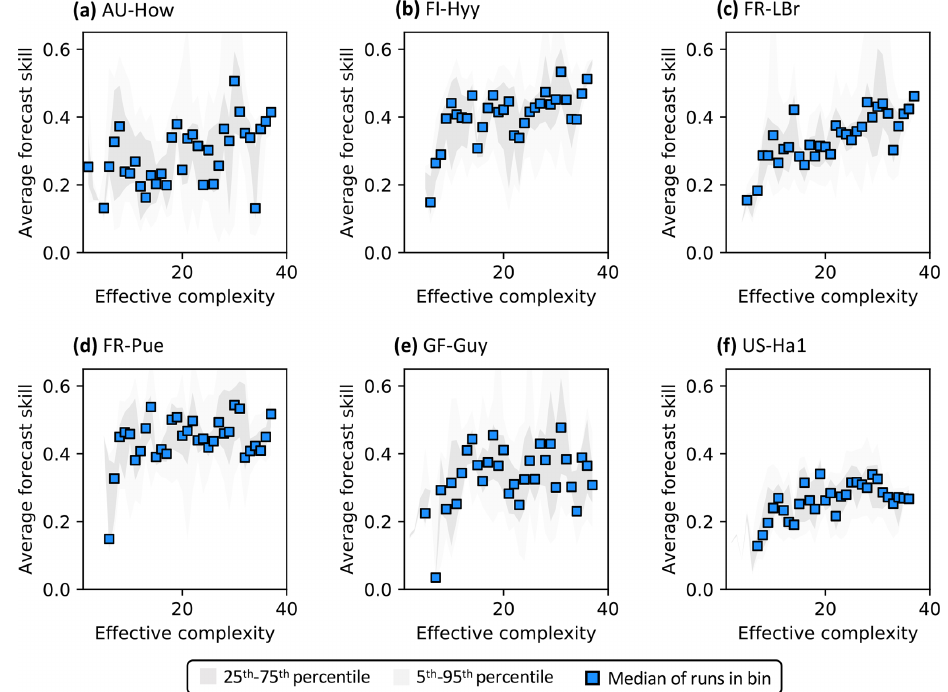
Figure 7. Complexity–skill relationship for NEE predictions, split by site (title of each subplot). Only runs for which data were assimilated are plotted. Average forecast skill is computed using the histogram intersection